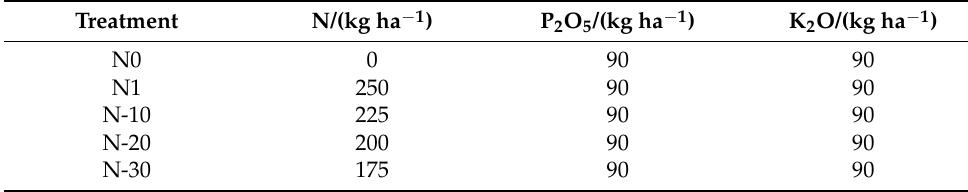
Table 2. Experimental treatment design.